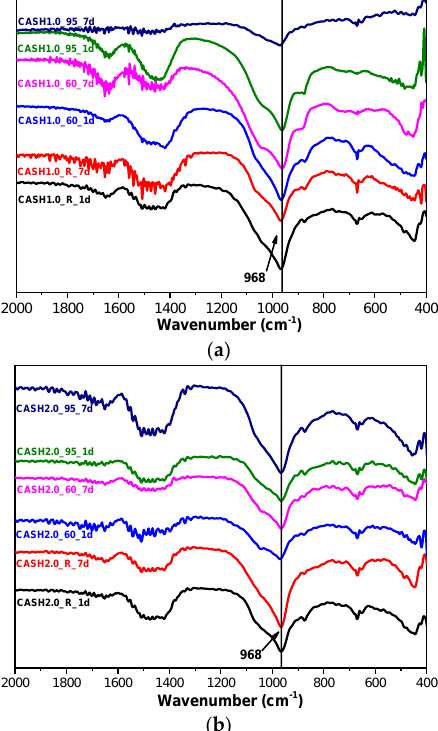
Figure 7. FTIR spectra of C-A-S-H system products. ( a ) CaO/SiO 2 is 1.0; ( b ) CaO/SiO 2 is 2.0.